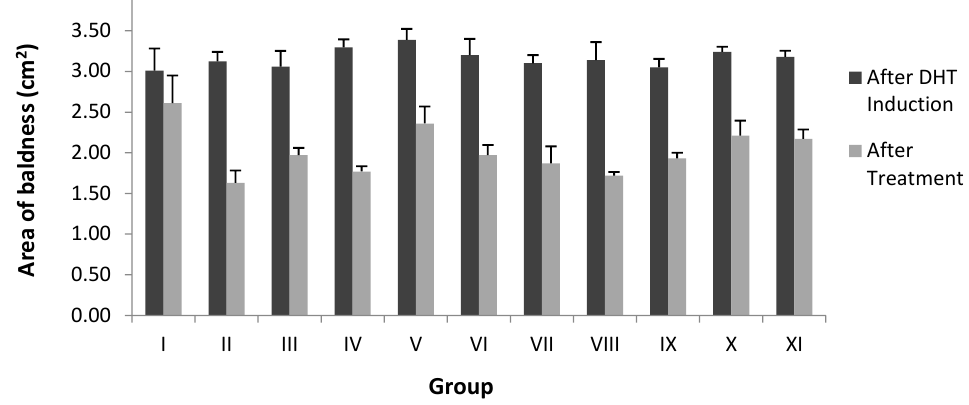
Figure 5. Graph of comparison area of baldness after DHT induction and after treatment .